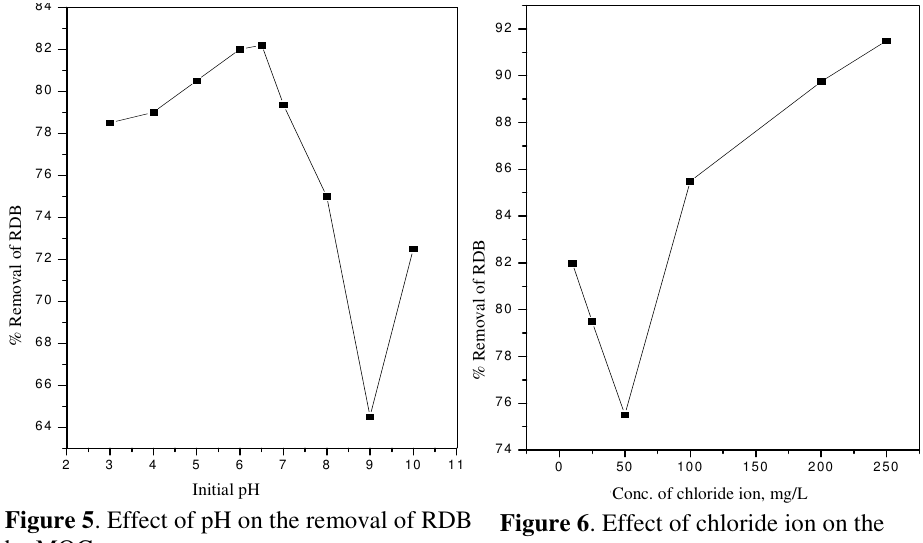
Figure 6 . Effect of chloride ion on the removal of RDB by